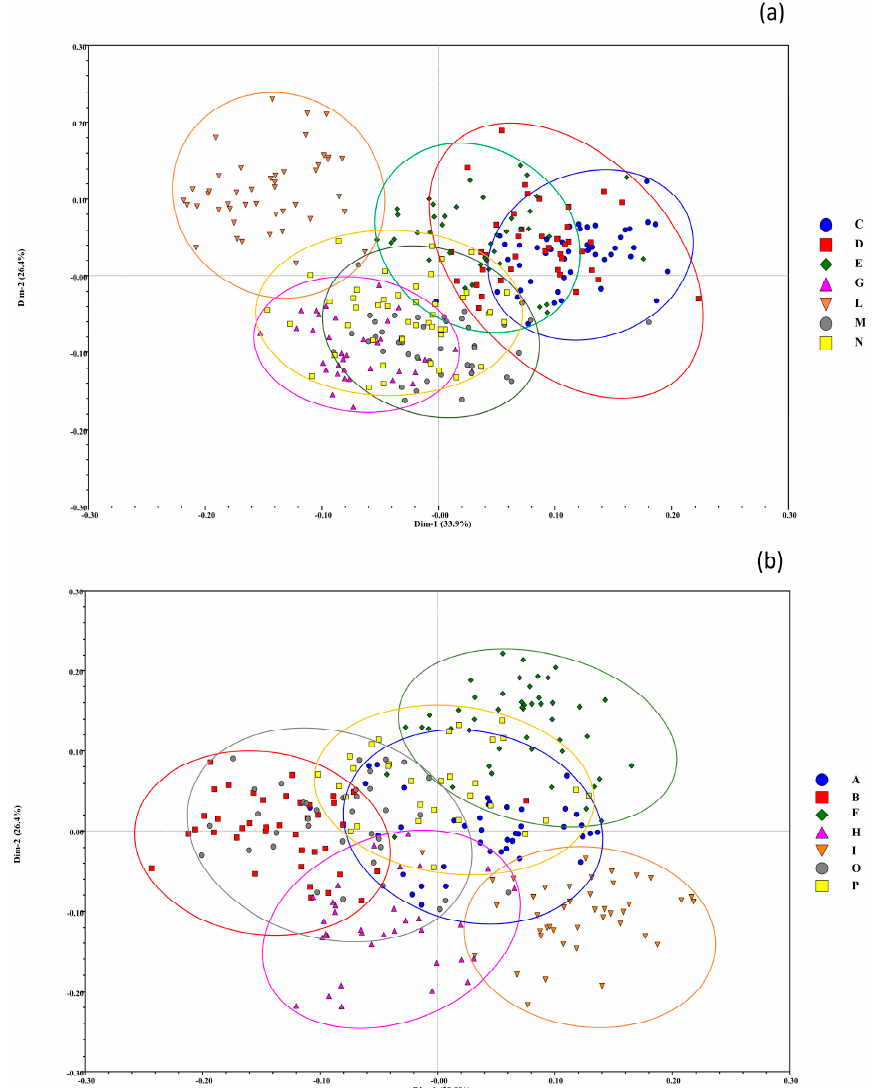
Figure 3. Principal coordinates analysis (PCoA) based on the GS matrix calculated with Rohlf’s coefficient in all possible pairwise comparisons. Samples are labeled following the biotype of belonging (identified by different colors and letters), and their centroids are subgrouped to better represent overlapping areas. ( a ) PCoA of biennial varieties. ( b ) PCoA of annual varieties.